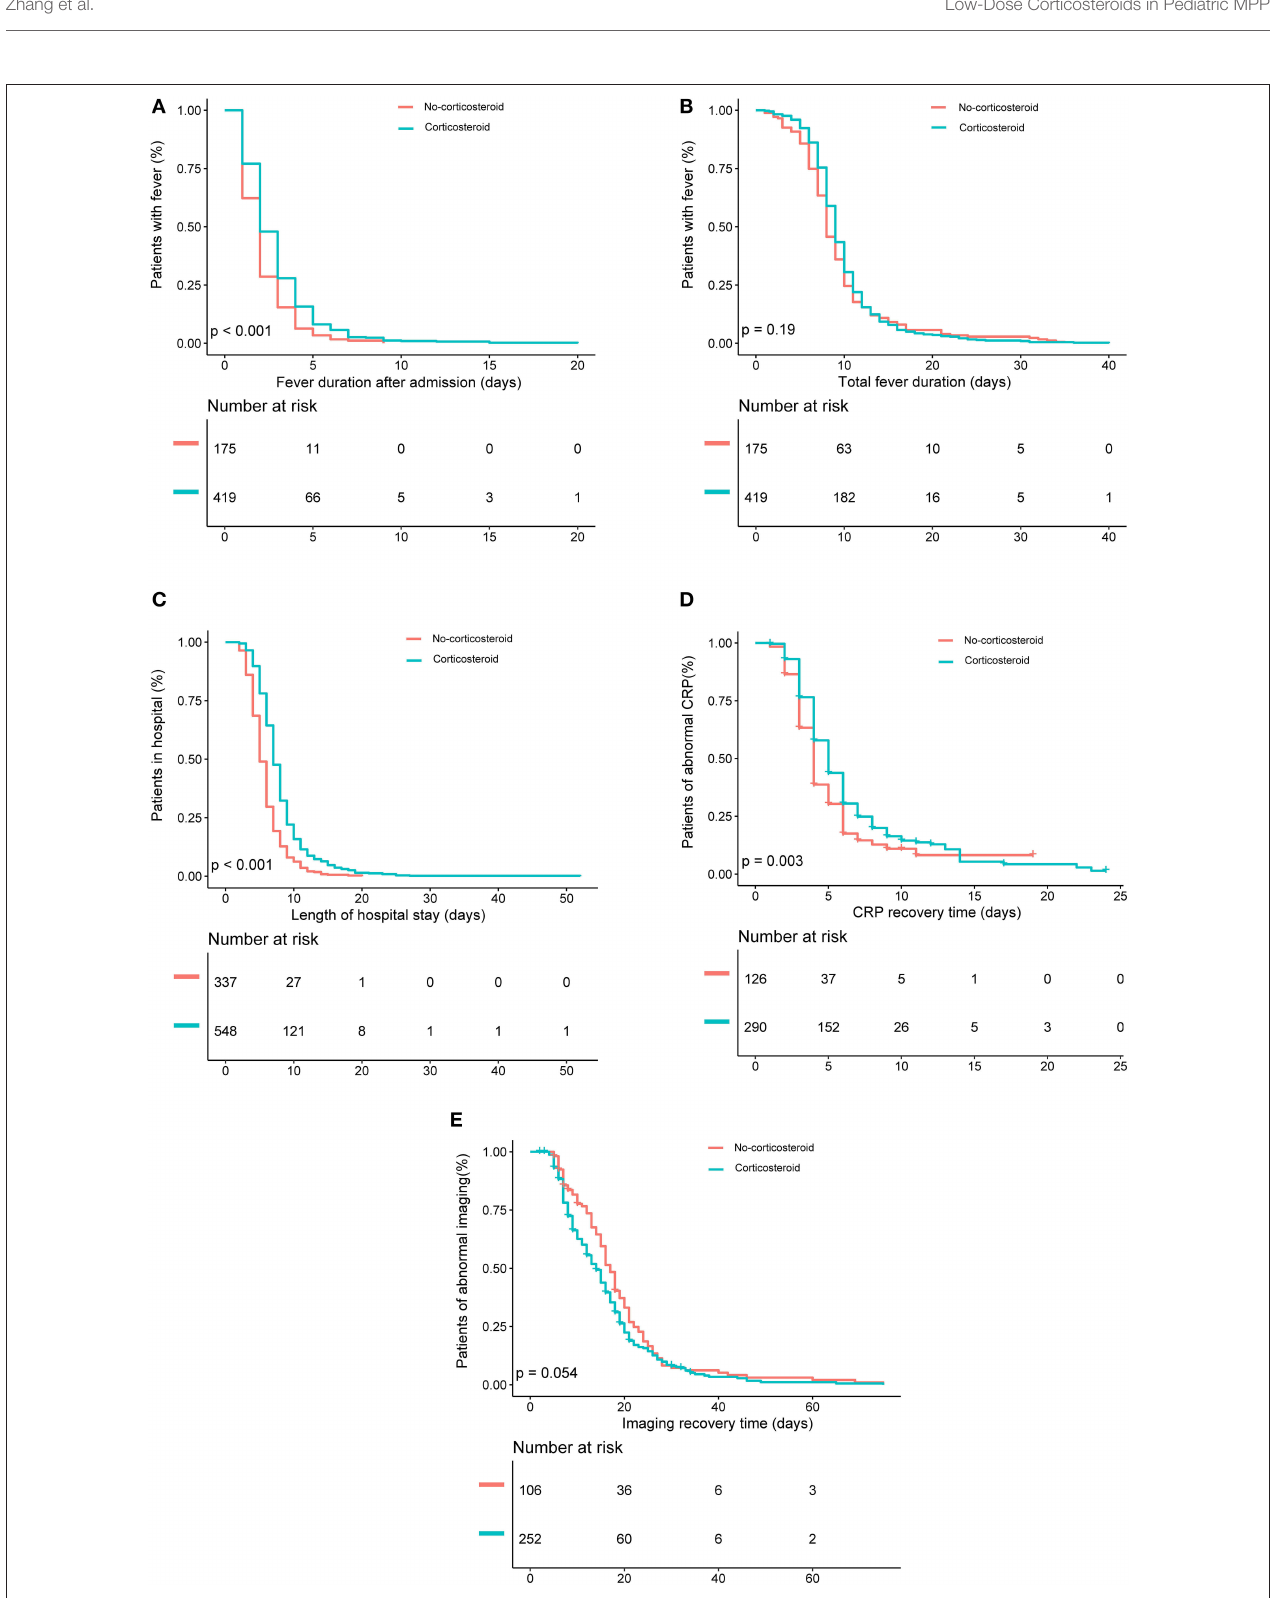
FIGURE 2 | Kaplan–Meier analysis of the effects of low-dose corticosteroid treatment on (A) fever duration after admission, (B) total fever duration, (C) length of hospital stay, (D) C-reactive protein (CRP) recovery time, and (E) imaging recovery time in the entire patient sample.